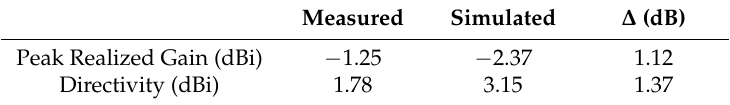
Table 7. Comparison between measured and simulated radiation characteristics of the antenna in free-space. Measured Simulated